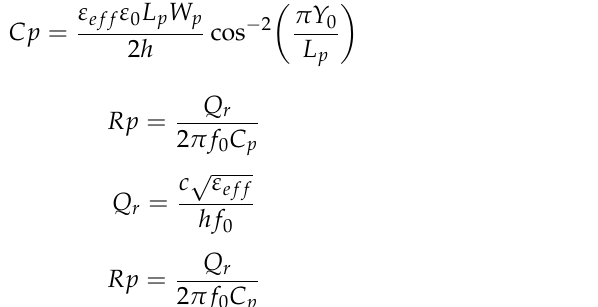
from CST and SPICE equivalent models